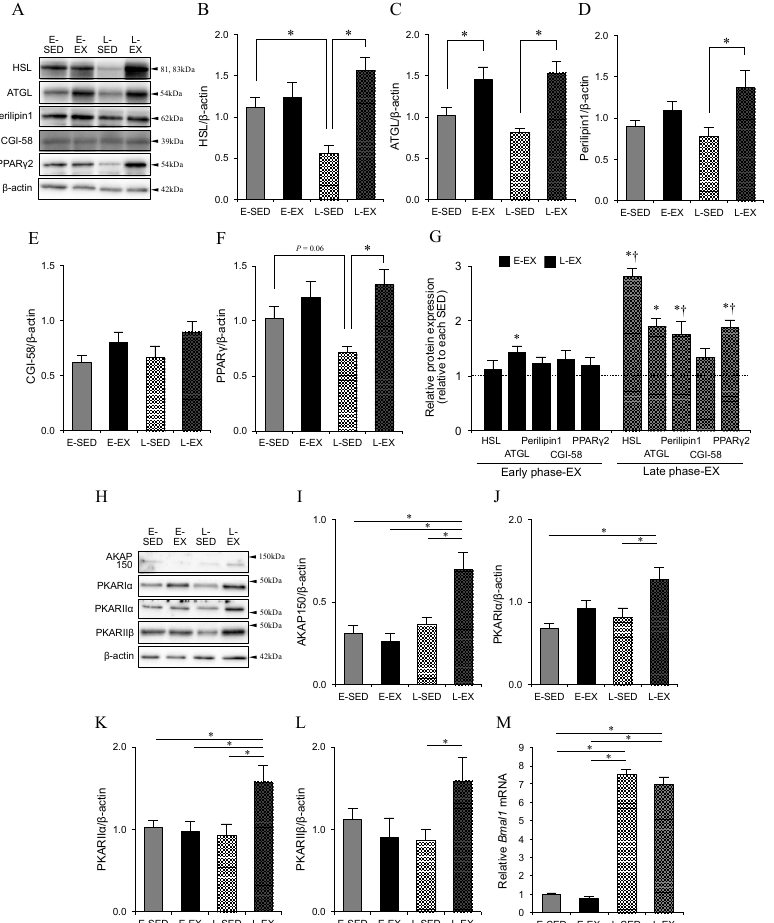
Figure 5. E ff ect of exercise training timing on the levels of lipolysis-associated proteins in primary adipocytes isolated from epididymal adipose tissues. ( A ) Representative immunoblotting data and the relative amounts of ( B ) HSL, ( C ) ATGL, ( D ) perilipin1, ( E ) CGI-58, and ( F ) PPAR γ 2 protein, in primary isolated adipocytes from rats, measured by Western blotting and normalized to the amount of β -actin. ( G ) Relative protein expression levels of each band in the E-EX and L-EX groups (levels in respective sedentary controls were set to 1). ( H ) Representative immunoblotting data and the relative levels of ( I ) AKAP150, ( J ) PKA-RI α , ( K ) PKA-RII α , and ( L ) PKA-RII β protein measured by Western blotting and normalized to the level of β -actin. ( M ) Bmal1 mRNA expression level measured by quantitative real-time PCR and normalized to the level of 18S rRNA. In all experiments, data are presented as the means ± S.E. ( n = 6). * p < 0.05, SED group vs. EX group. † p < 0.05, E-EX vs. L-EX. The abbreviations for the groups of rats are shown in Figures 2 and 3.